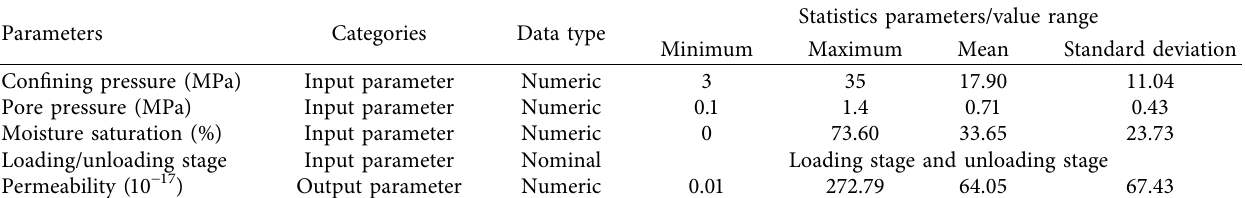
Table 1: The statistical description of the input and output parameters.